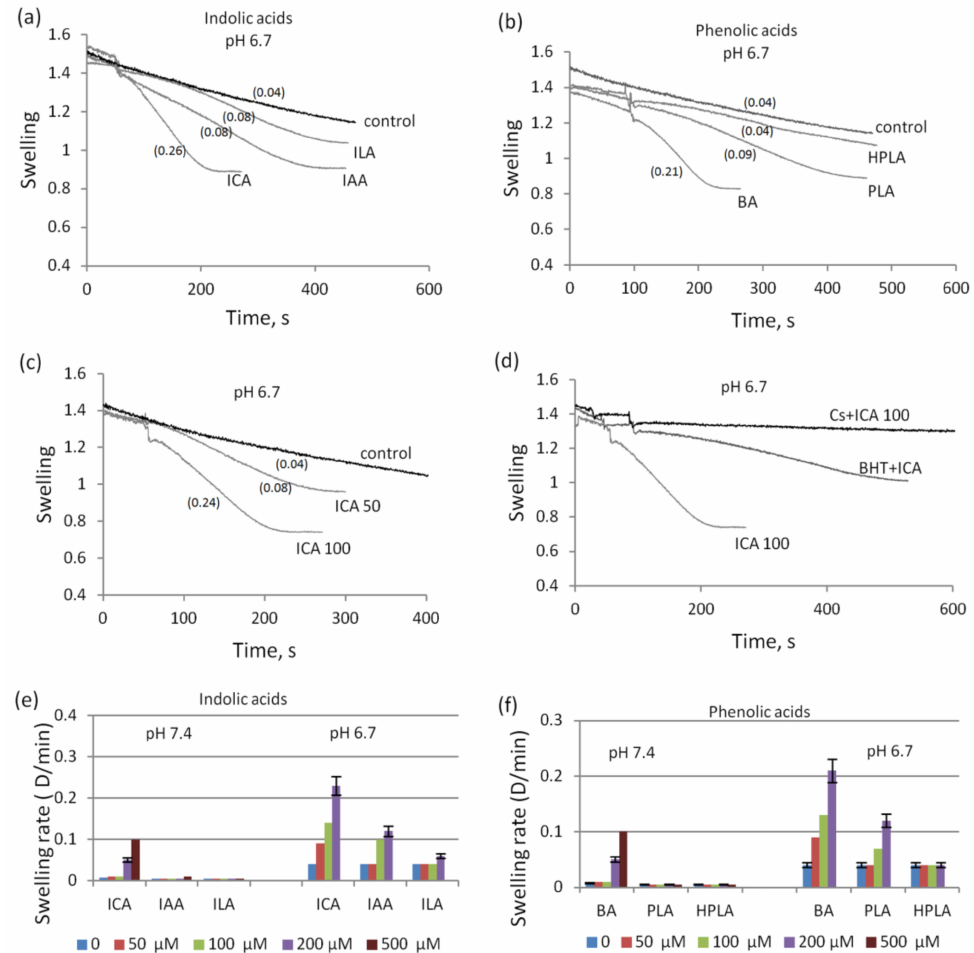
Figure 5. Influence of indolic and phenolic acids on mitochondrial swelling activated by acidification. Activation of swelling by indolic ( a ) and phenolic ( b ) acids at a concentration of 100 µ M each during incubation at pH 6.7; swelling in the presence of 50 and 100 µ M ICA ( c ) and its inhibition by CsA and BHT ( d ); comparison of the swelling rate in the presence of indolic ( e ) and phenolic ( f ) acids at different concentrations (50–500 µ M) at pH 7.4 and 6.7. The swelling rate ( ∆ /min) is indicated in